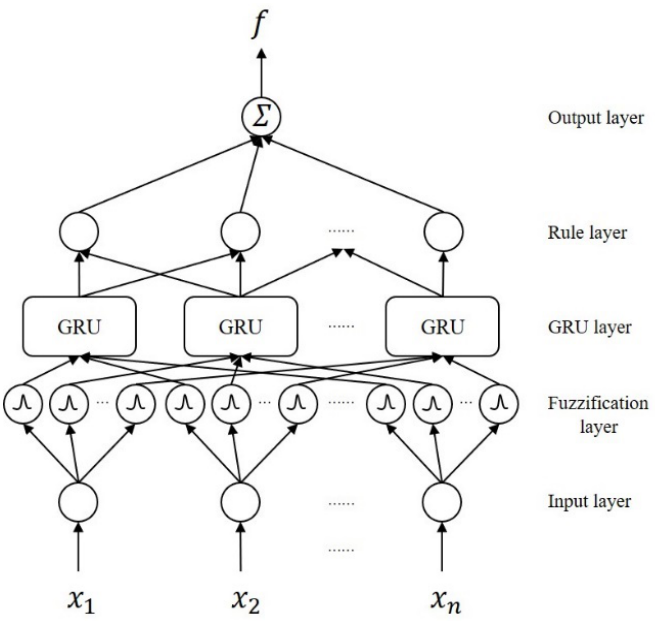
Figure 2. Structure of the GRFNN.